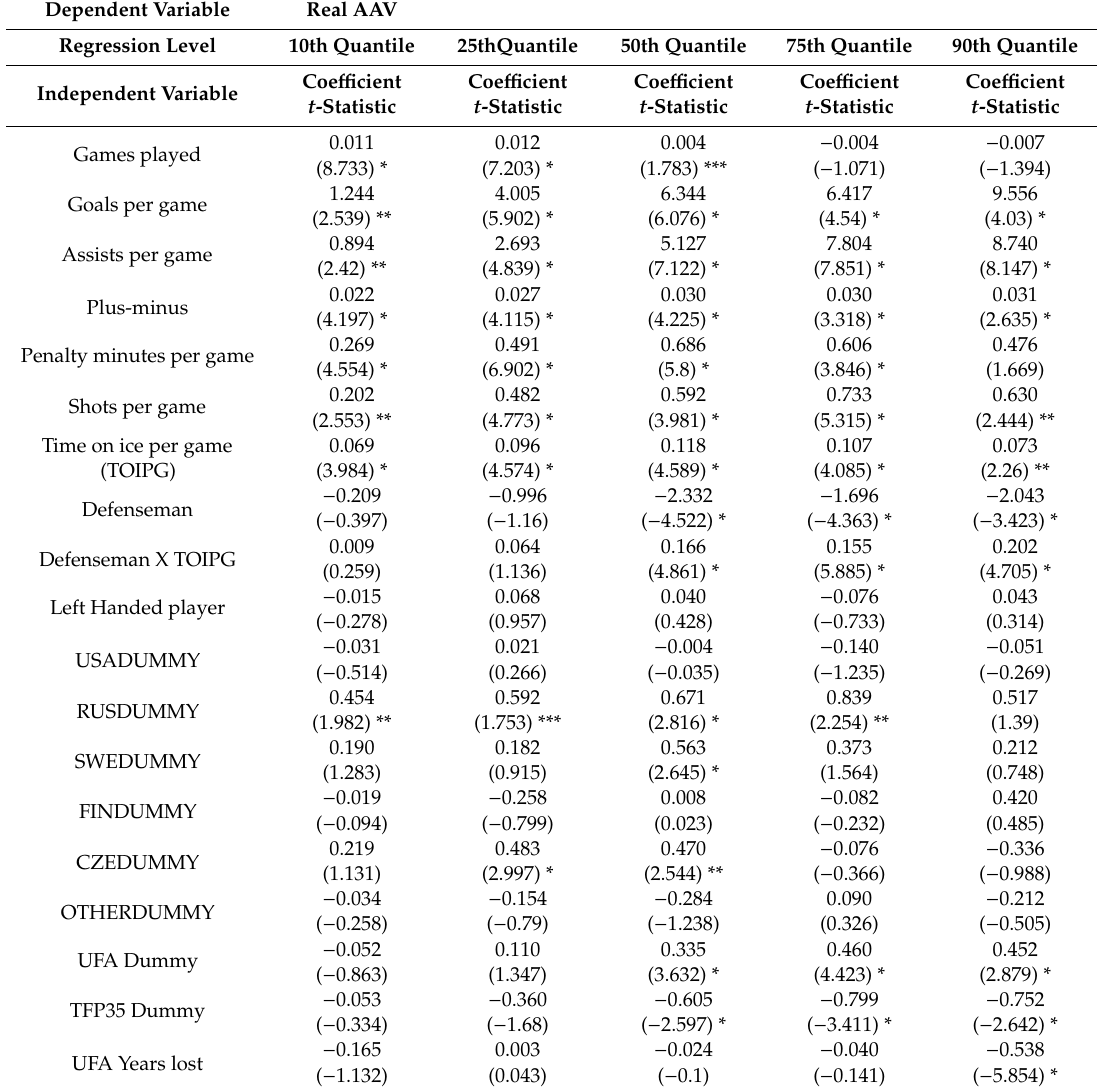
Table 4. Quantile regression results based on previous contract